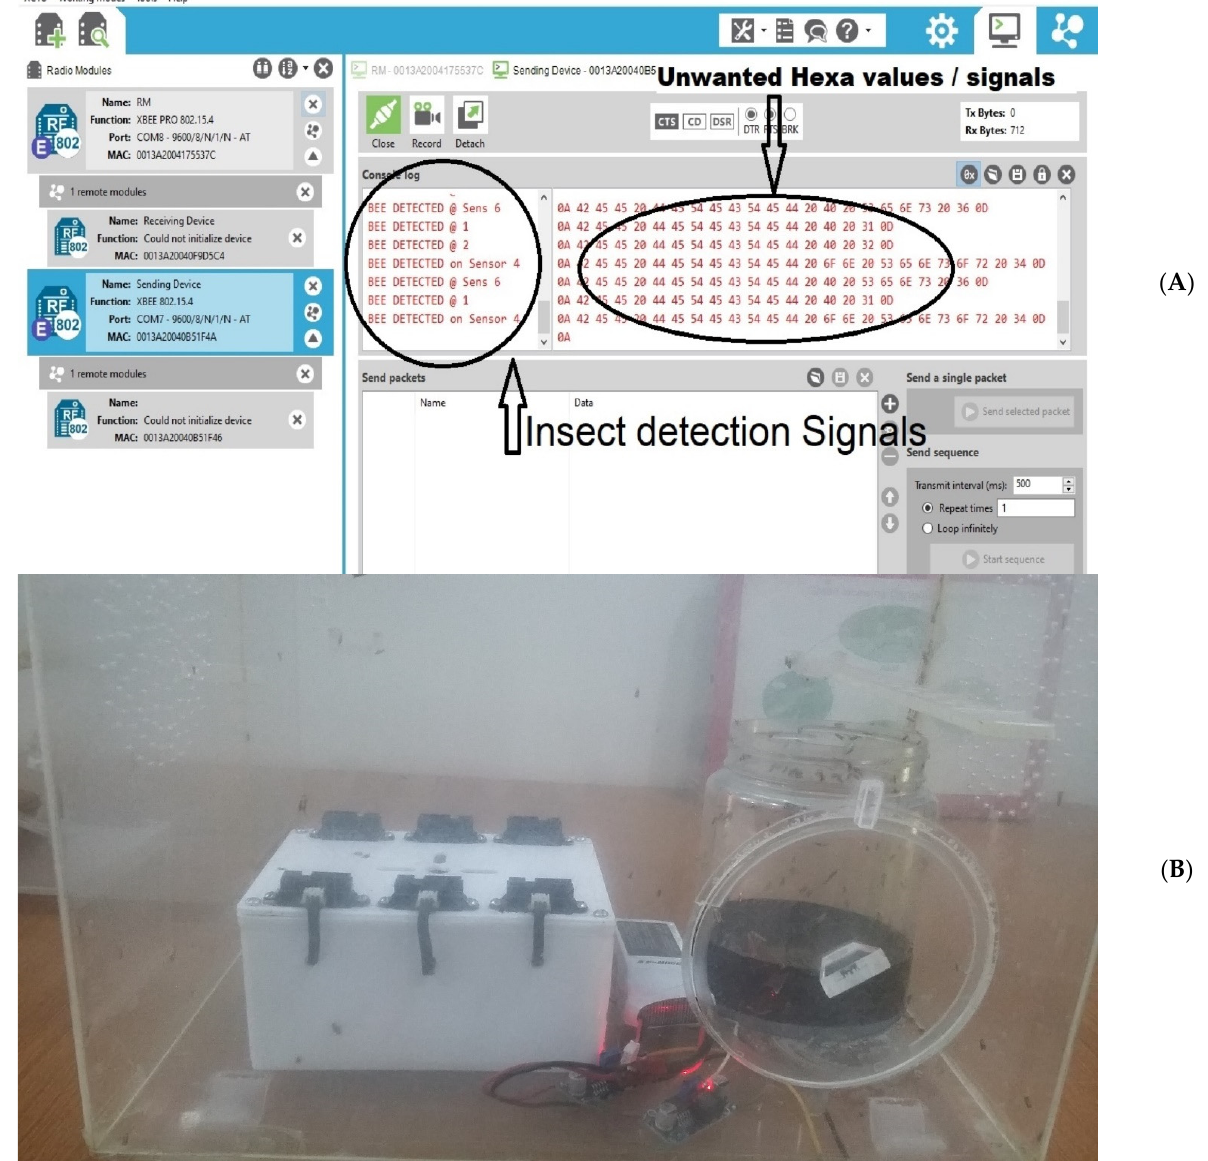
Figure 3. ( A ). Results received on Zigbee console monitor with some unwanted values. ( B ) Acrylic box for an experiment. box for an